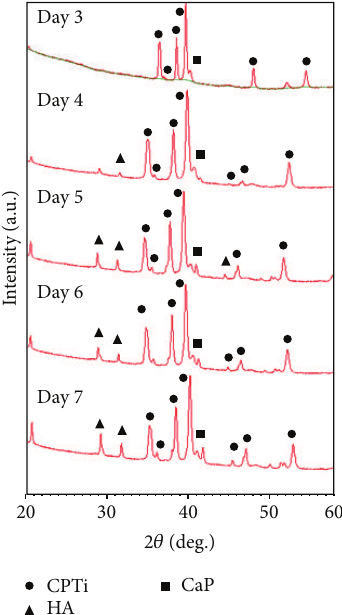
Figure 4: Showing the XRD analysis of the surface on various days of the experiment.